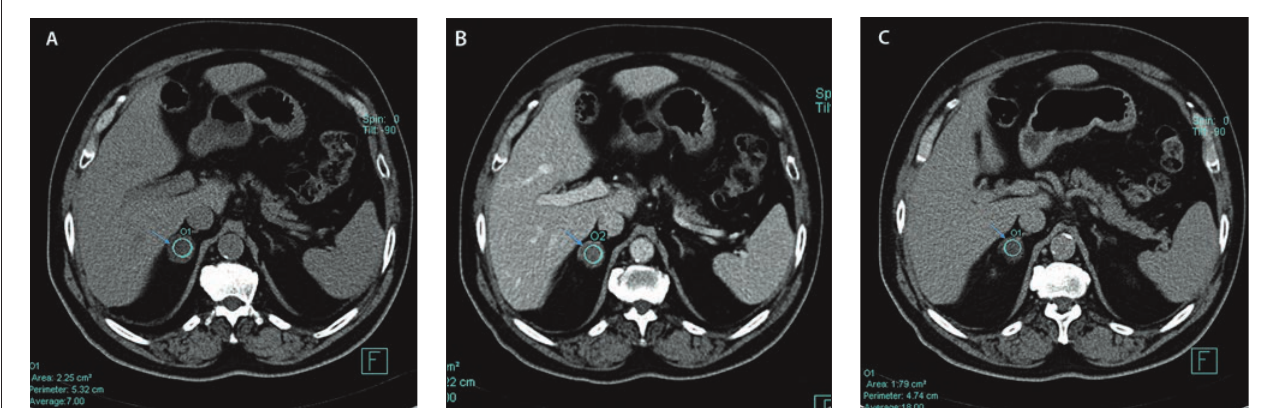
Fig.1. Adrenocortical adenoma in a 45-year-old woman with Cushing syndrome. (A) Axial precontrast CT image demonstrates a homogenous, well-defined right adrenal mass (blue arrow) with HU of 7. Imaging could have stopped here as the unenhanced CT density (HU <10) is consistent with a lipid-rich adenoma. (B) At 60 seconds post contrast, the HU measures 43 (blue arrow). (C) Delayed post-contrast image at 15 minutes demonstrates a HU of 18. The corresponding absolute percentage washout (APW) is 69%, confirming the diagnosis of an adenoma (blue arrow).